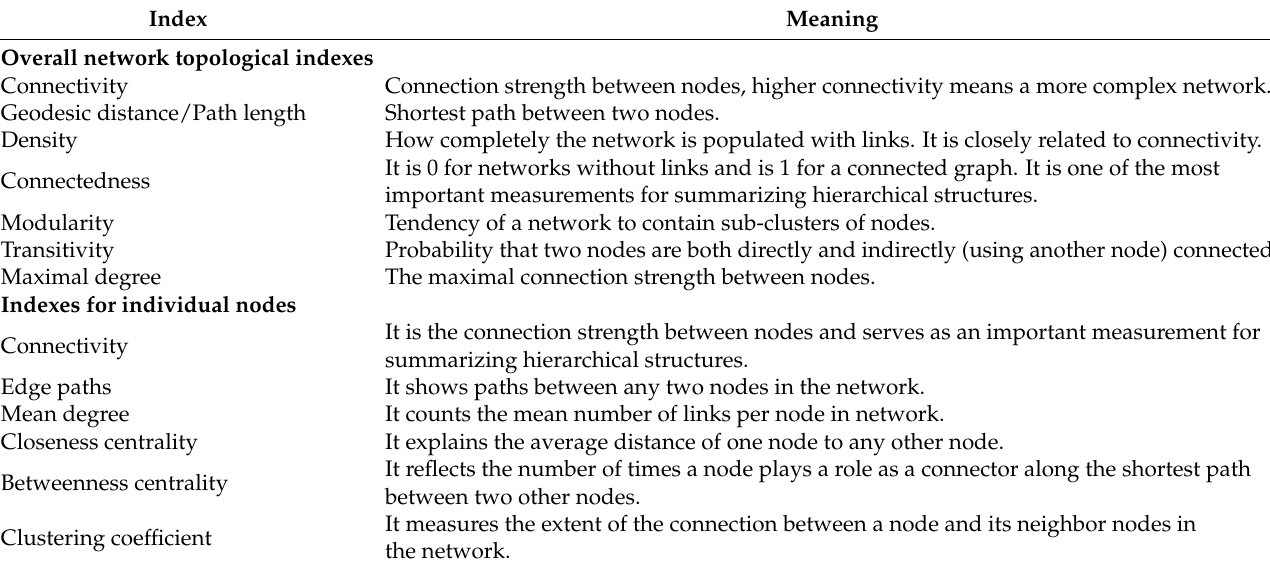
Figure 1. Schematic representation of a taxonomic co-occurrence network. Each circle represents a node (i.e., microbial OTU/ASV). A line connecting two nodes represents a positive or negative interaction between them (link). Nodes grouped into gray zones represents modules (i.e., clusters of densely interconnected nodes). Table 1. Common topological indexes used to characterize networks and nodes. Adapted from Dai et al. [50] and Deng et al.